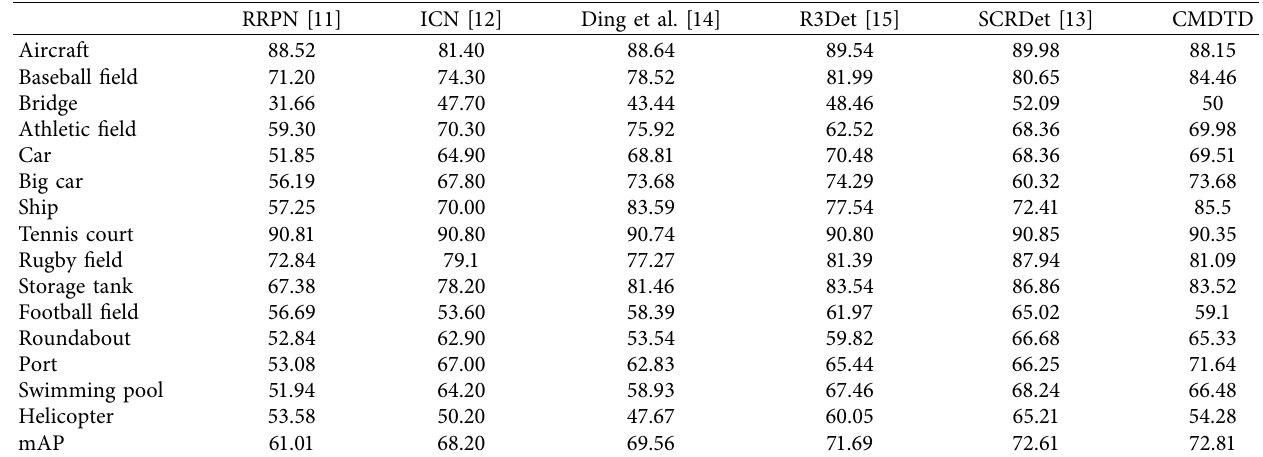
Table 2: Comparison results of DOTA task 1